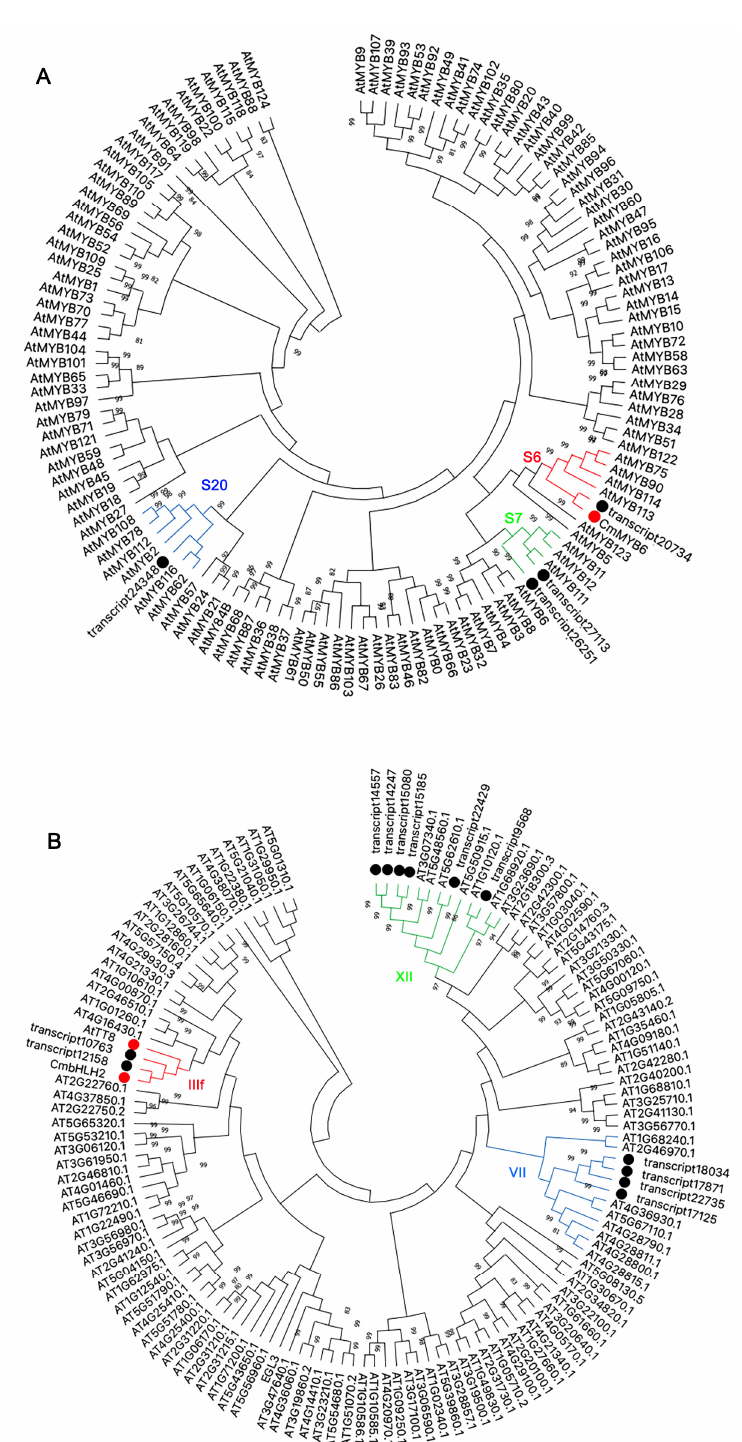
Figure 4. Phylogenetic analysis of CmMYBs and CmbHLHs together with MYBs and bHLHs of Arabidopsis , respectively. ( A ) CmMYBs were analyzed together with 126 MYBs from Arabidopsis , 4 differentially expressed MYBs were marked with a black solid circle. Reported anthocyanin regulators were marked with a red solid circle. ( B ) CmbHLHs were analyzed together with 120 bHLHs from Arabidopsis , 12 differentially expressed bHLHs were marked with a black solid circle. Reported anthocyanin regulators were marked with a red solid circle. Neighbor-joining trees were constructed with 1000 replications of